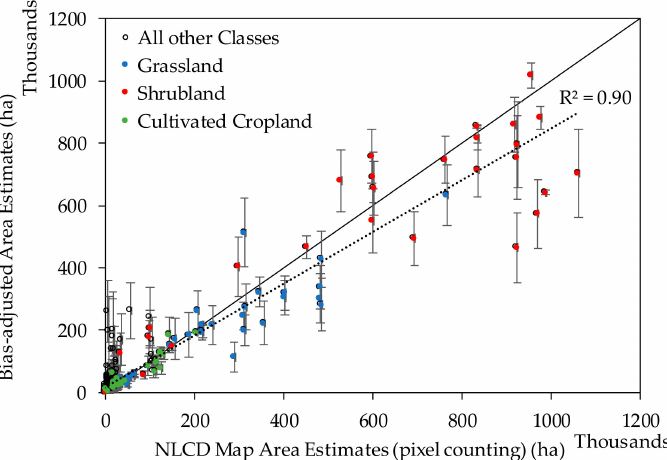
Figure 6. Comparison between bias adjusted and NLCD map (pixel counting) area estimates over each class over the study